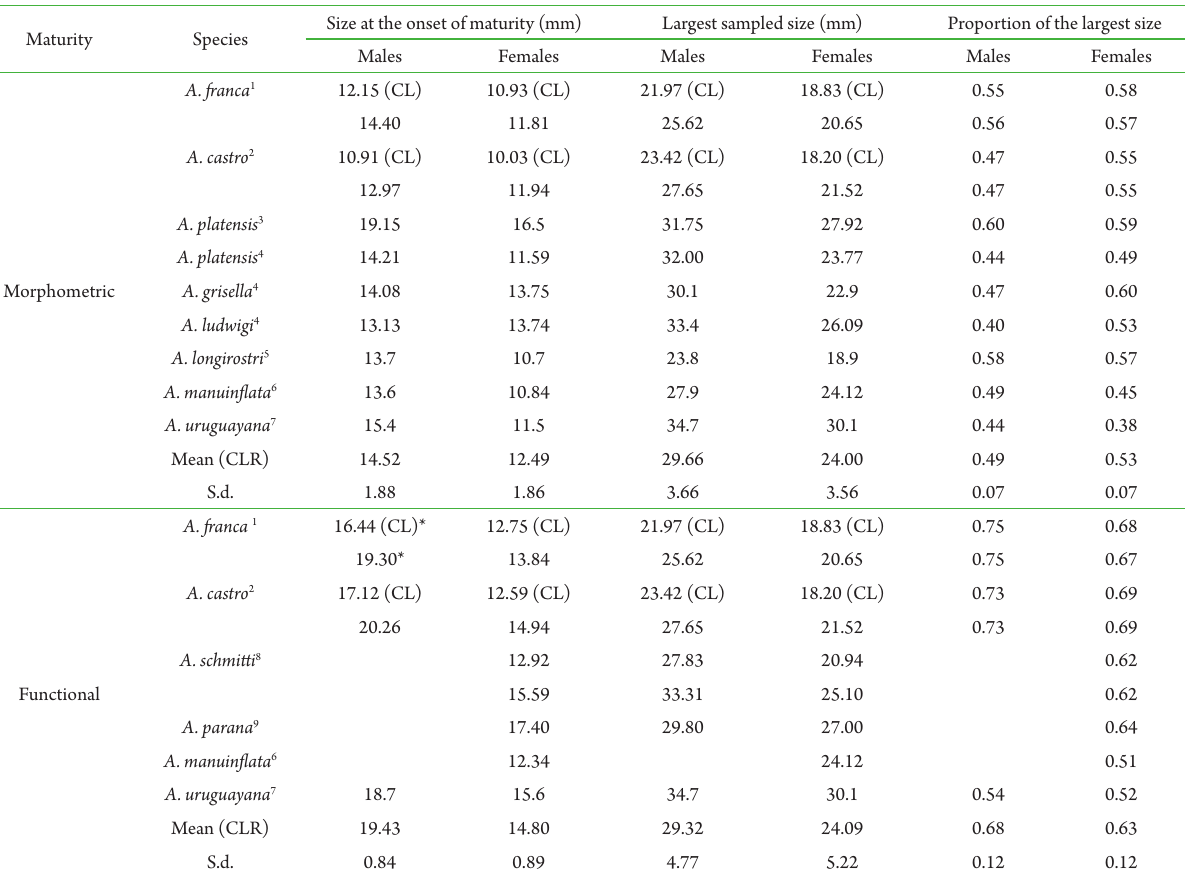
Table 4. Carapace length (rostrum included except where noted) at the onset of morphological and functional maturity and correspondent proportion in relation to the largest sample size of Aegla species. Species are ordered in accordance to study site latitudes (low to high). S.d. = standard deviation. 1 - Bueno and Shimizu (2009); 2 - Present study; 3 - Oliveira and Santos (2011); 4 - Copatti et al . (2015); 5 - Colpo et al . (2005); 6 - Trevisan and Santos (2012) and Santos et al . (2009); 7 - Viau et al . (2006); 8 - Chiquetto-Machado et al . (2016); 9- Grabowski et al ., 2013. * - Values recalculated after adoption of dataset restriction as described in the Material and methods